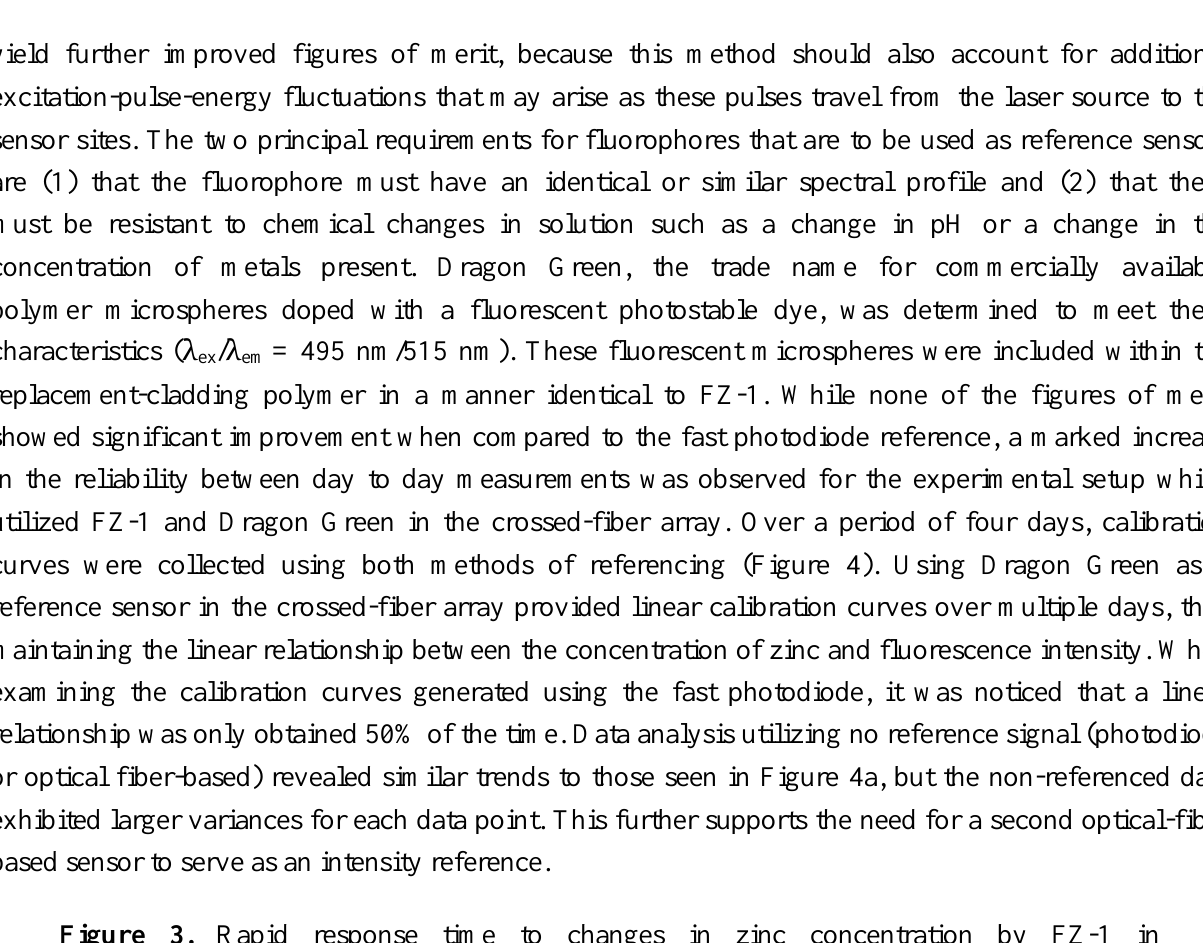
Figure 3. Rapid response time to changes in zinc concentration by FZ-1 in micro-templated polymer